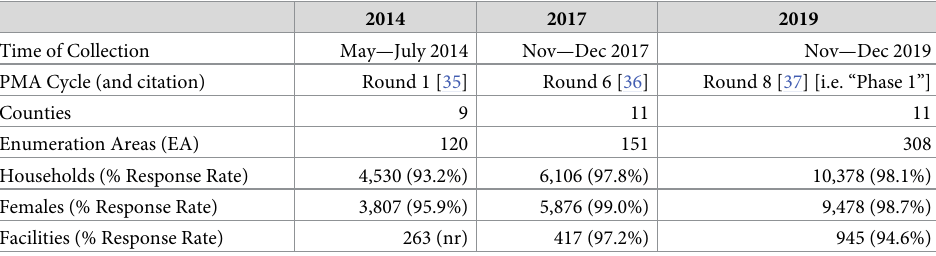
Table 1. Description of PMA survey enumeration, PMA/Kenya (2014, 2017,